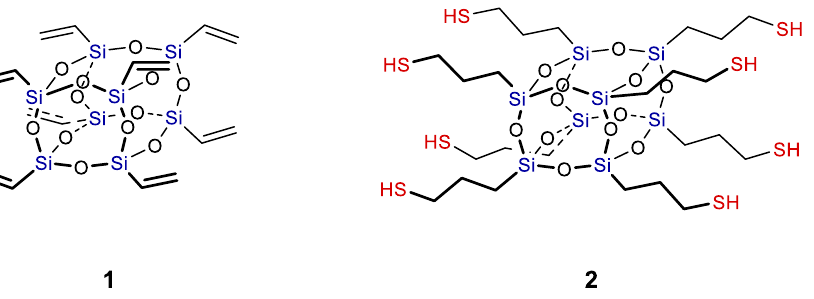
Figure 15. Pentacyclo-[9.5.1.1 3,9 .1 5,15 .1 7,13 ]-octasiloxane, 1,3,5,7,9,11,13,15-octaethenyl ( 1 ) and Penta- Figure cyclo [9.5.1.13,9.15,15.17,13]octasiloxane-1,3,5,7,9,11,13,15-octapropanethiol ( 2 ).